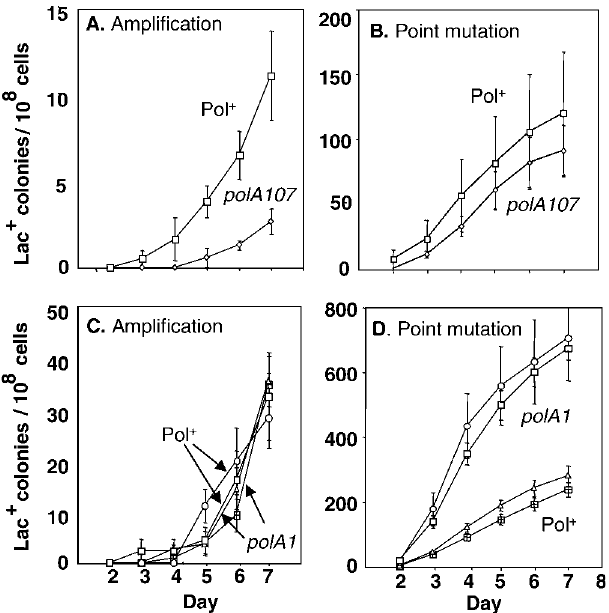
Figure 4. The Flap-Endonuclease Activity of DNA Polymerase I Promotes Adaptive Amplification with No Effect on Point Mutation: Lagging Strands Implicated